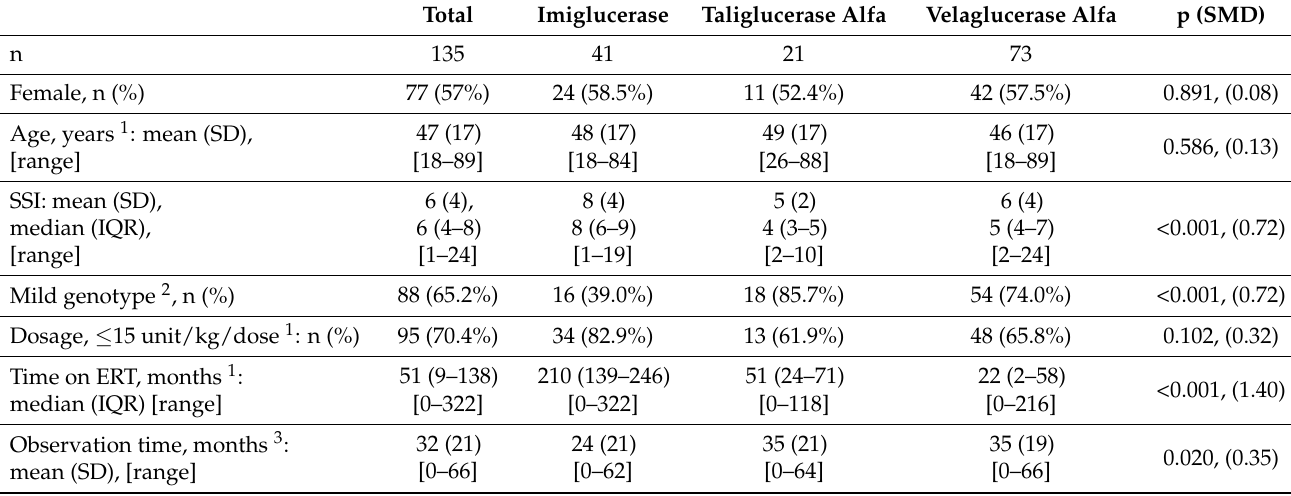
Table 1. Characteristics of 135 patients with Gaucher disease type 1 who were treated with a single type of ERT.